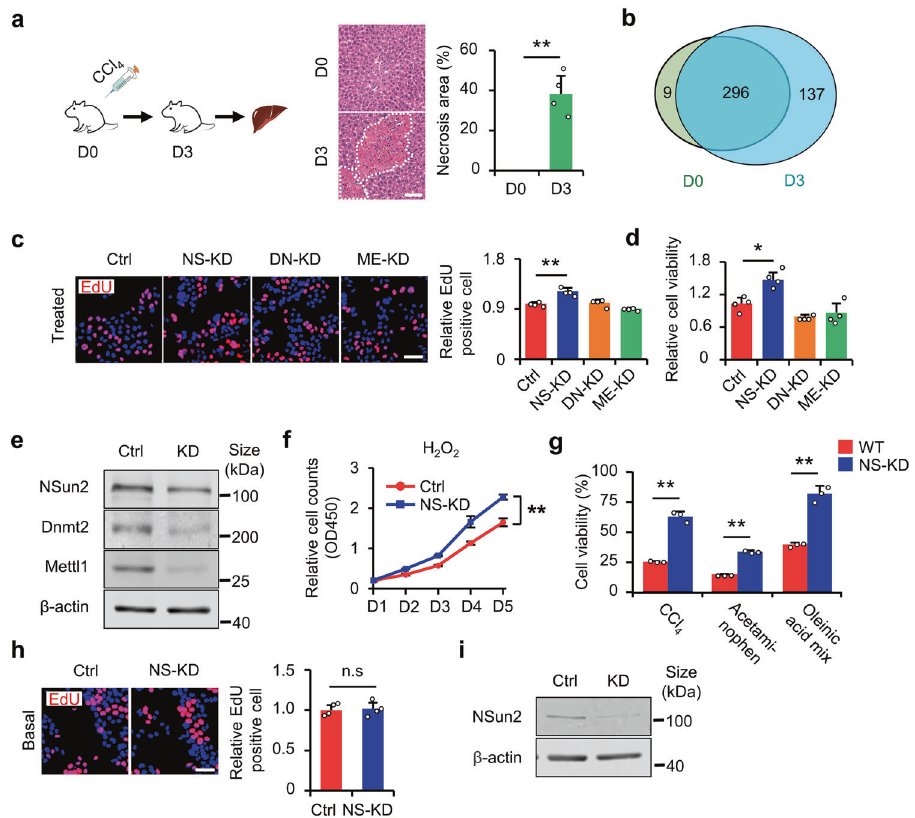
Fig. 1 NS-KD alleviates cell injury. a CCl 4 -induced liver injury. Left panel: schematic of the construction of liver injury mice models. Liver injury was induced by CCl 4 injection. The lower part indicates the time, i.e., D0: intraperitoneally (i.p.) injection of CCl 4 or vehicle on day 0. D3: assessing the extent of liver injury on day 3. Right panel: H&E staining showing hepatic necrosis following injection of vehicle (D0) or CCl 4 (D3). Dotted lines indicate the necrotic or in fl ammatory area, and the percentage of the necrotic or in fl ammatory area is quanti fi ed. Scale bar, 50 μ m; n = 4 mice. b Venn diagram showing the numbers of tsRNAs in the presence or absence of CCl 4 stress. The color represents samples with or without CCl 4 stress. The numeral is the number of tsRNAs in the corresponding area. The data are acquired by tsRNA-seq, and each group comprised two duplicate samples. c The effect of four tRNA modi fi cation enzymes on HL-7702 proliferation under H 2 O 2 stress. Treated: H 2 O 2 . Left panel: representative images of EdU staining are shown. Right panel: statistical results. Scale bar, 100 μ m. EdU-positive cells were analyzed as data relative to the control n = 4 replicates. d Relative HL-7702 viability (CCK-8 assay) was assessed by detecting the OD450 value. n = 4 replicates. e NSun2 expression was measured to verify the knockdown effect of NSun2 by western blotting in ( c ) and ( d ). f Detection of HL-7702 proliferation using CCK-8 assay under H 2 O 2 stress at the indicated time points (day 1, day 2, day 3, day 4, day 5), ** P < 0.01, versus control siRNA at day 5. g Detection of transfected HL-7702 cell survival after stimulation with other chemicals. HL-7702 viability was assessed by the CCK-8 assay. n = 3 replicates. h Detection of transfected HL-7702 cell proliferation in the absence of stress damage. Basal: no H 2 O 2 . Left panel: representative images of EdU staining. Right panel: statistical results. Scale bar, 100 μ m. EdU-positive cells were analyzed relative to the control. n = 4 replicates. i NSun2 expression was measured to verify the knockdown effect of NSun2 by western blotting for ( f – h ) and Supplementary Fig. S1j. NSun2 siRNA: NS-KD; Ctrl siRNA: Ctrl. All data are expressed as the mean ± SD. * P < 0.05, ** P < 0.01, n.s . no signi fi cance, Student ’ s t